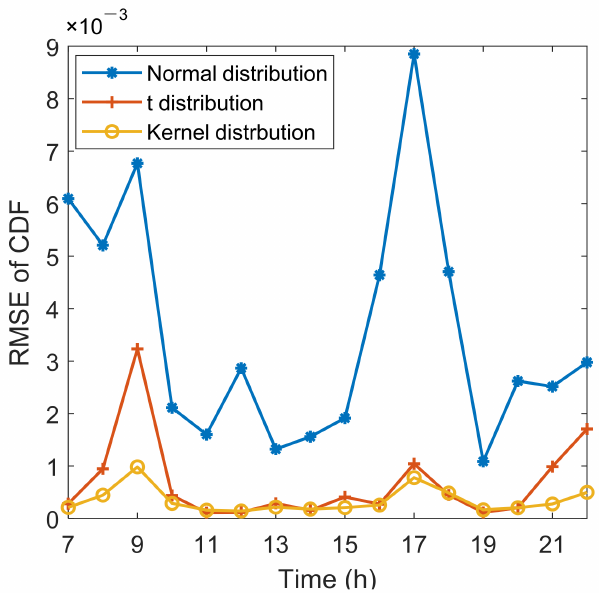
Figure 4. RMSE comparison of different distribution